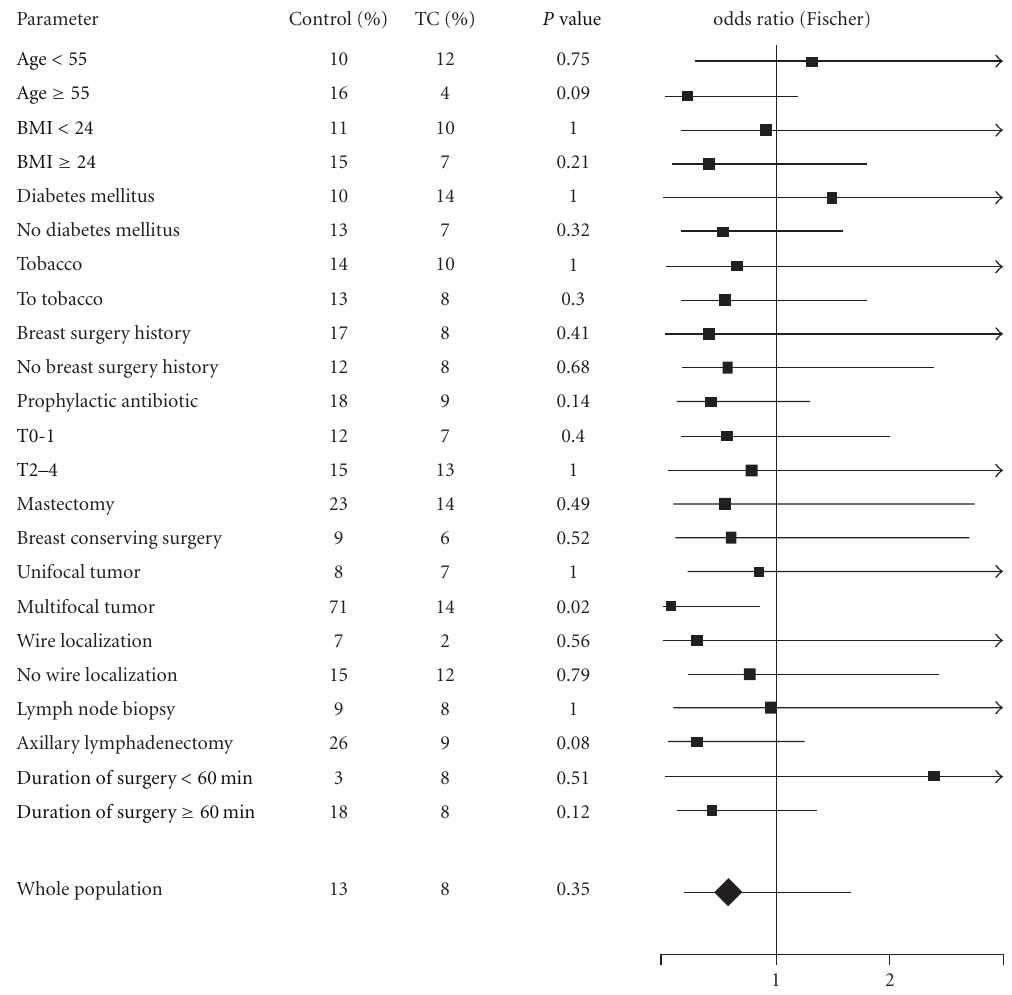
Figure 1: Forest plot representing odds ratios and their confidence intervals for subgroups.